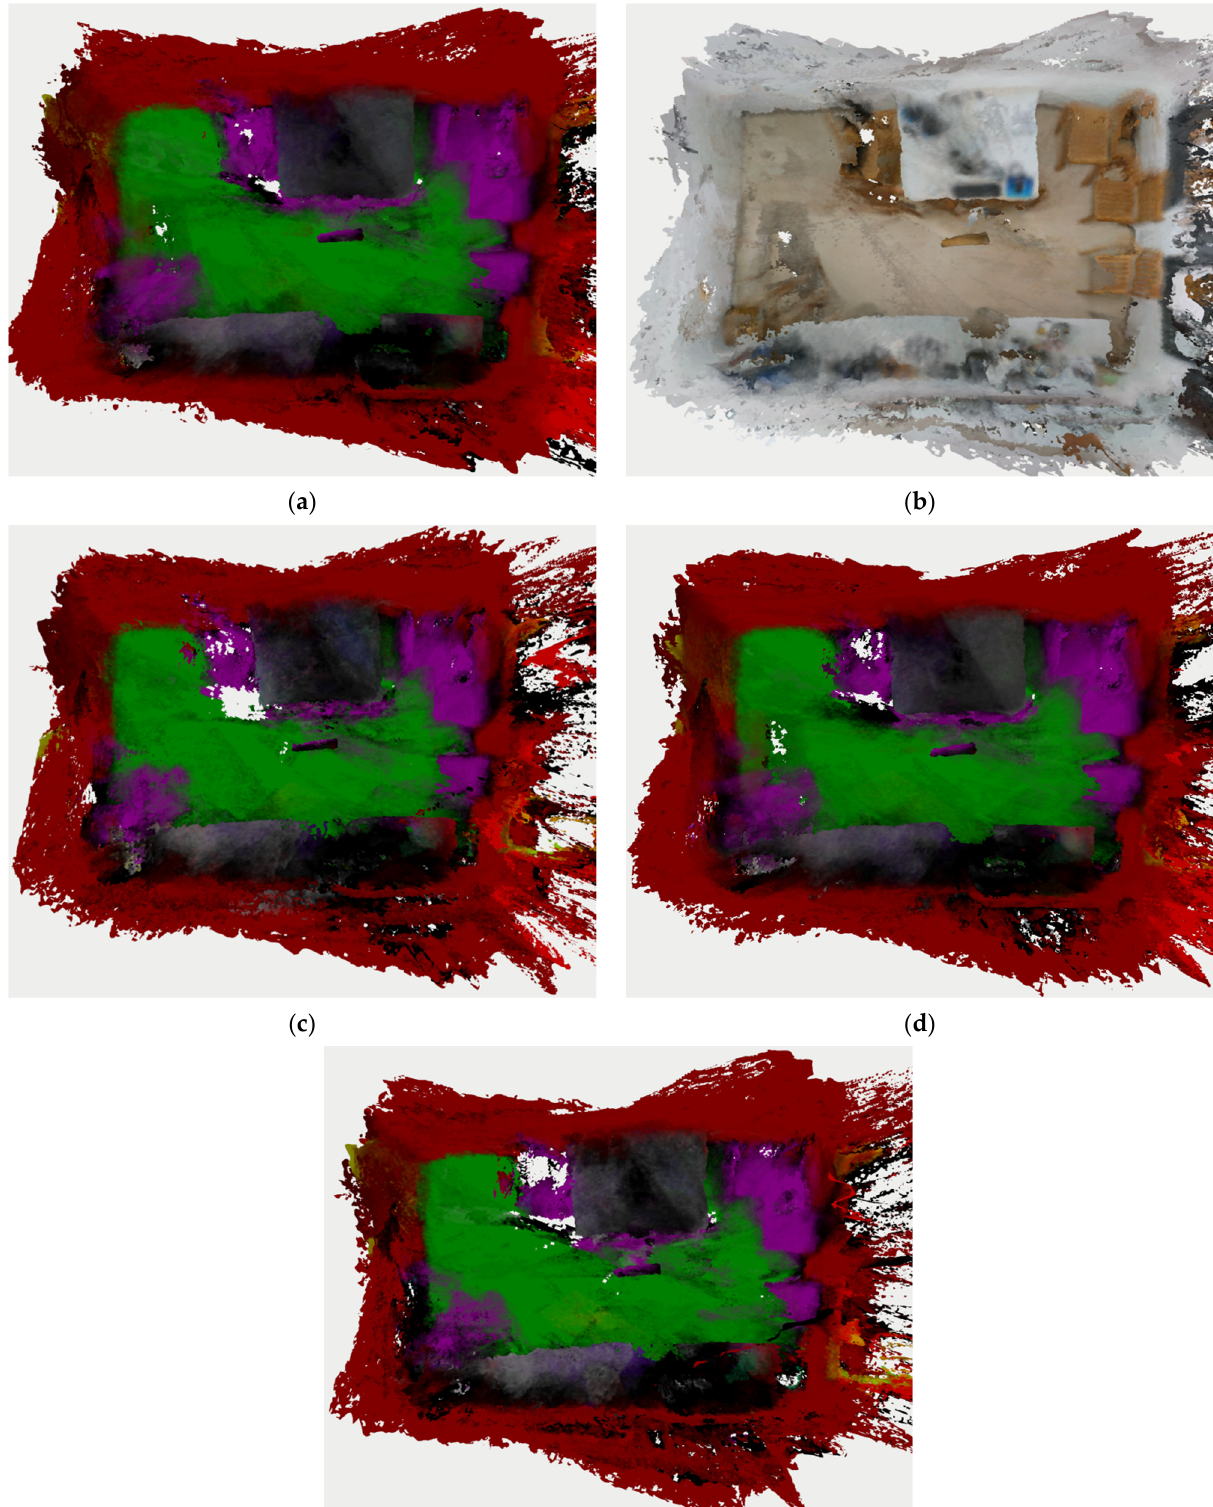
Figure 5. Reconstructed results of the office dataset. ( a ) Semantic map of groundtruth, ( b ) textured map of groundtruth, ( c ) semantic reconstructed result of GDSSLAM, ( d ) semantic reconstructed result of Kimera and ( e ) semantic reconstructed result of our method